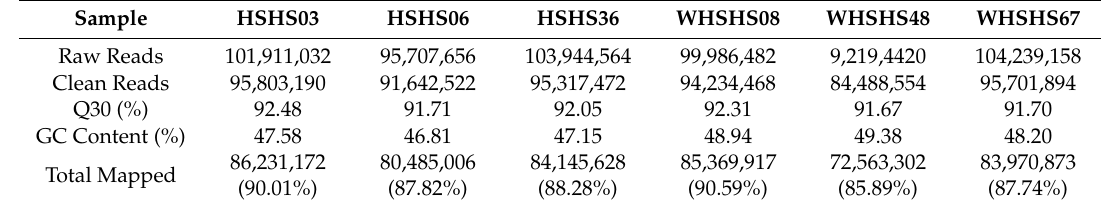
Table 2. Summary of clean reads mapped to the Ovis aries reference